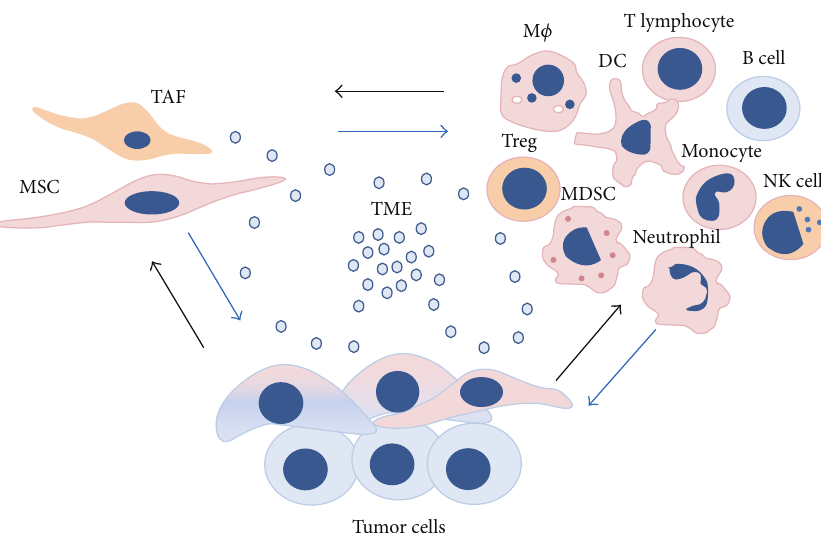
Figure 1: Tumor microenvironment (TME) as a fertile ground for dynamic cell phenotype and function. Composition of TME implies immediate vicinity of mesenchymal stromal/stem cells (MSCs), tumor-associated fibroblasts (TAFs); immune cells: macrophages (M B ), regulatory T cells (Treg), myeloid-derived suppressor cells (MDSCs), natural killer (NK) cells, dendritic cells (DCs), monocytes, neutrophils, T lymphocytes, B cells, and heterogenic population of tumor cells. Reciprocal communication within cellular compartment is accomplished through the paracrine